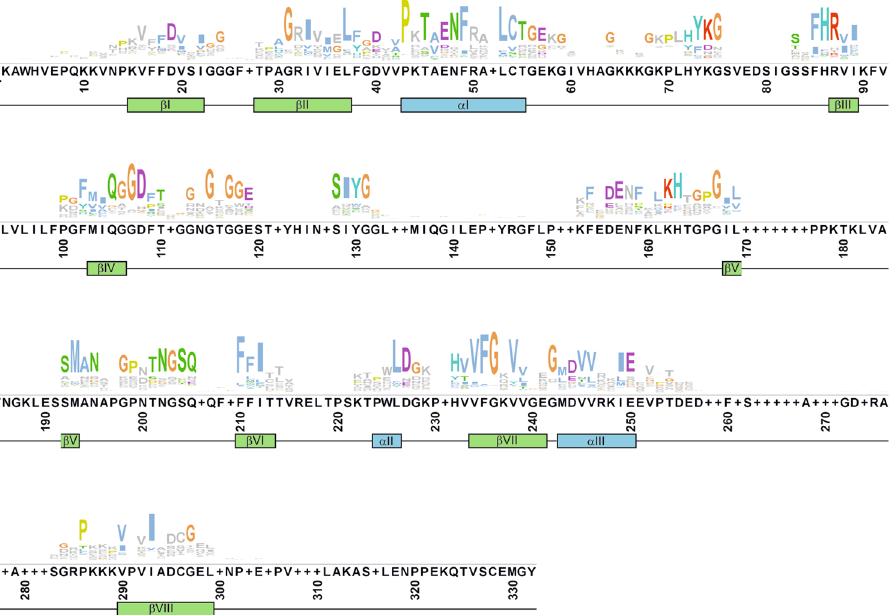
Figure 1. Conserved sequence of the B. napus cyclophilin-like domain. CYP protein sequences were cropped to the predicted sequence for the CLD and aligned with the secondary structure of hCypA. The